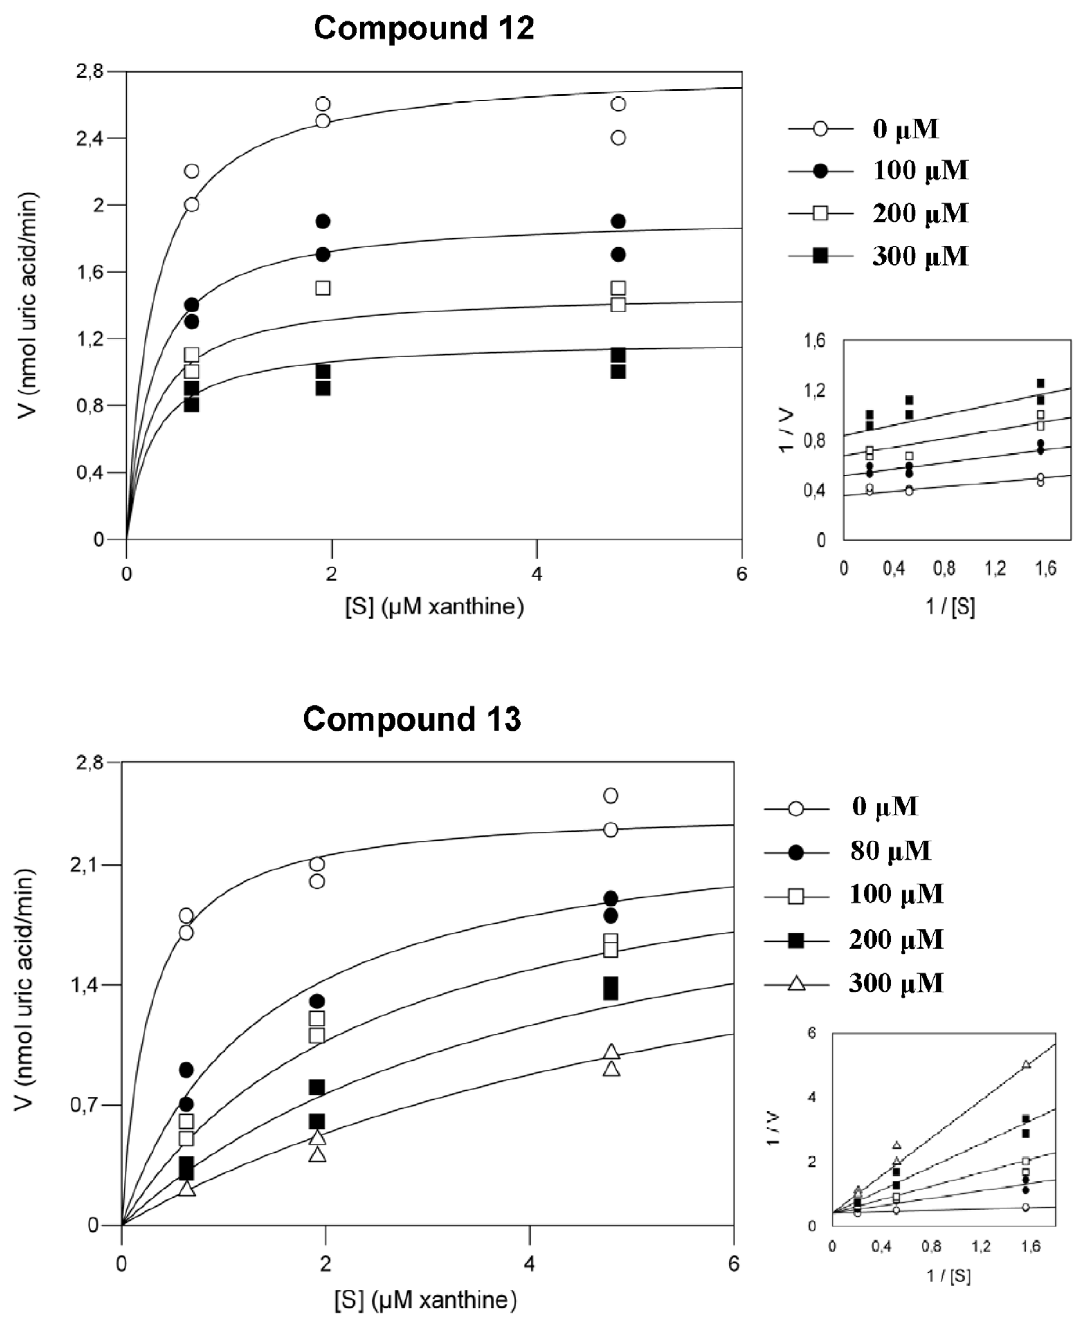
Figure 2. Kinetic analysis plots of the compounds 12 and 13.